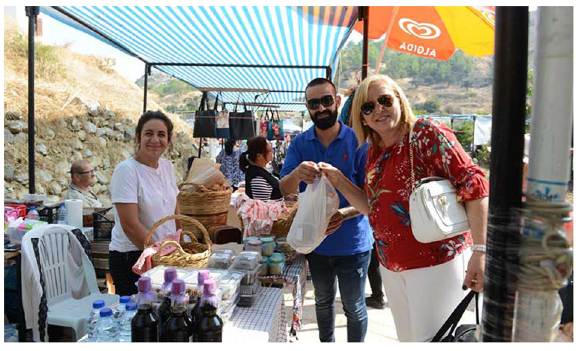
Fig. 2 Ampelikou village eco-day activity. Ampelikou: a view from eco-day.